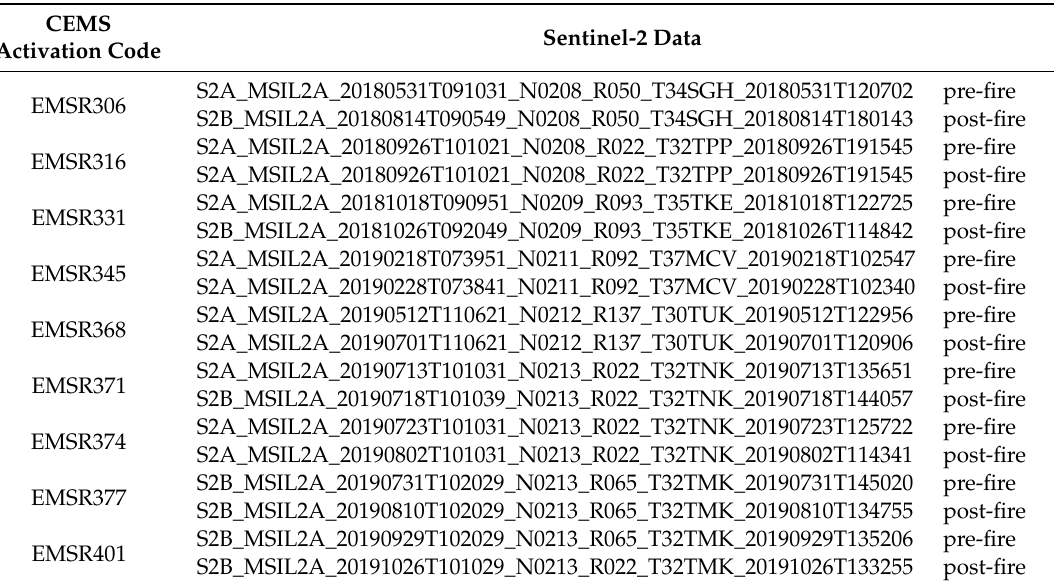
Table 4. S2-L2A tiles used in this study for BA